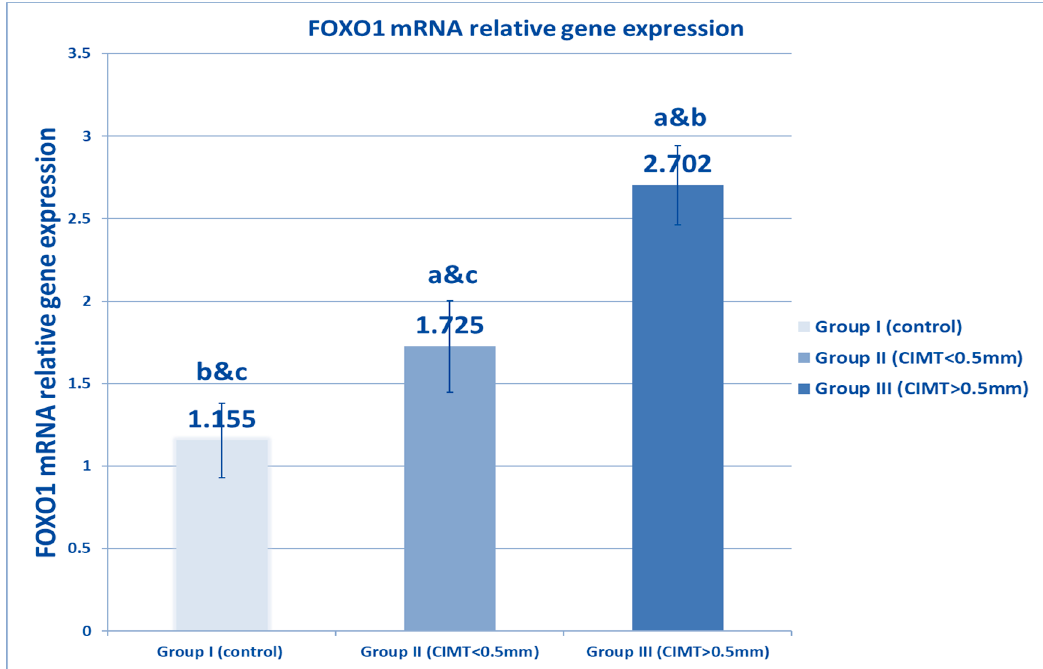
Figure 3. Comparison between studied groups with regard to FOXO1 mRNA relative to the gene expression level. Data are represented as mean ± SD ( n = 50 in each group). Statistical analysis was carried out using one-way ANOVA with Tukey’s post hoc test, SPSS computer program. a–c: Significant difference between groups at p < 0.05. a: significance from Group I; b: significance from Group II; c: significance from Group III. FOXO1: forehead box protein 1.